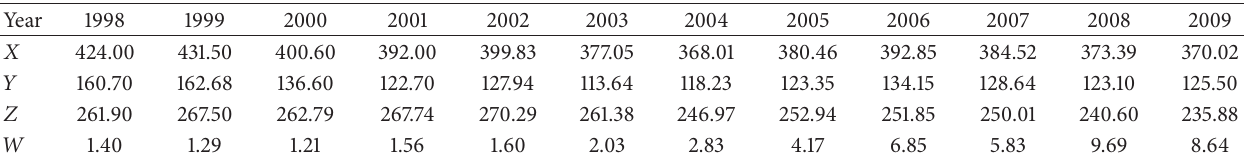
Table 1: Water resources statistic data in Haihe River Basin (Unit: billion m 3